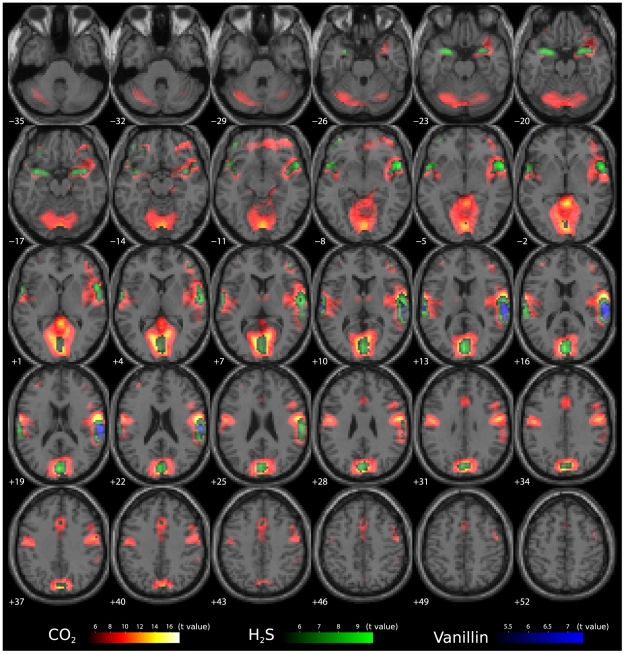
Activations following nociceptive and non-nociceptive stimuli.The trigeminal CO2 stimuli were associated with extended brain activations (contrast 1 0 0 −1 denoting CO2, H2S, vanillin and blank stimuli associated responses respectively). The significance at voxel level is colour-coded from dark red, low, to yellow, high, with increasing t values. Significant activations associated with the olfactory stimuli (contrasts 0 1 0 −1 and 0 0 1 −1) were less pronounced and less extended across the brain (colour depth of the displayed voxels reflects the respective t value of the voxel from dark green, low, to light green, high, for the H2S stimuli associated activations, and dark blue to light blue for the vanillin associated activations). The vanillin stimuli associated activations (blue) were completely within regions covered by the H2S associated activations (green) and both were almost within CO2 stimuli associated activations (red/yellow). Therefore, the pain associated activations were significantly stronger than the olfactory stimuli associated ones only in restricted regions, including the right insular cortex and bilaterally the rolandic operculum containing S2. Voxels are shown at a threshold of p<0.01 (FWE-corrected; t>5.091).